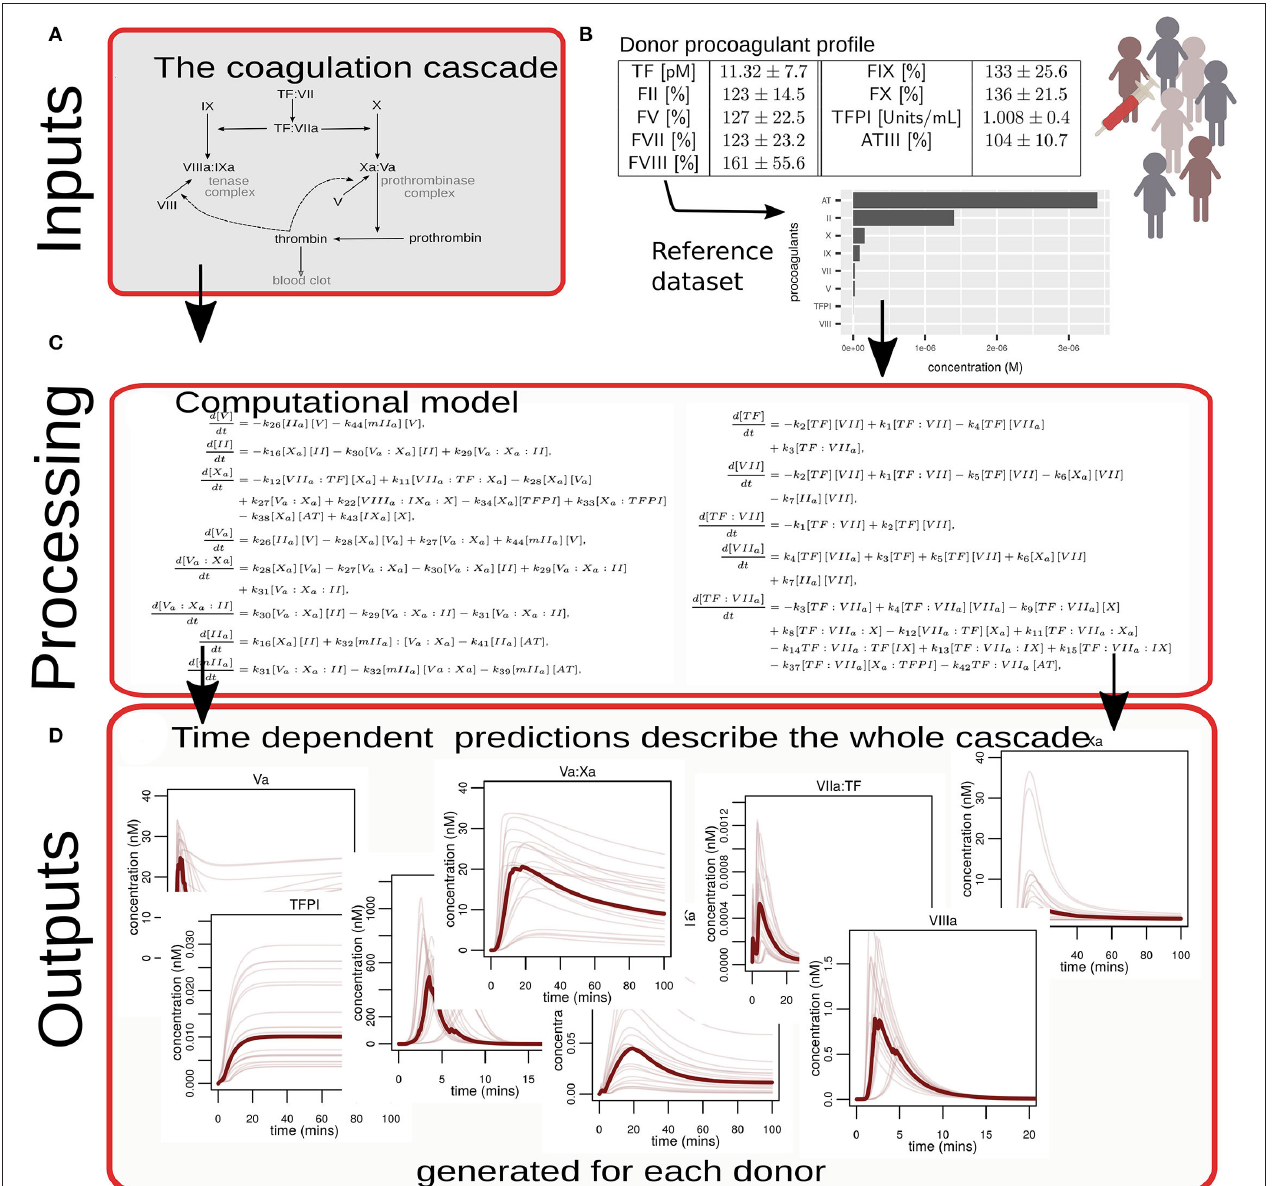
FIGURE 1 | Diagrammatic overview of the process used to convert experimental data into computational simulations of coagulation. (A) A biological description (in the form of a network diagram) of the reactions that comprise the coagulation cascade that was translated into a mathematical model. (B) Illustrates that coagulation proteins in plasma from 348 individual donors were measured, converted via a reference dataset to absolute concentrations, and used as model inputs. (C) Examples of numerical simulations of the mathematical model provide predictions. The equations shown here are for illustrative purposes only. The complete set of equations is given in the Supplemental File . (D) Illustrates examples of how all the proteins and complexes that comprise the coagulation cascade change and interact over time. These predictions were generated for each